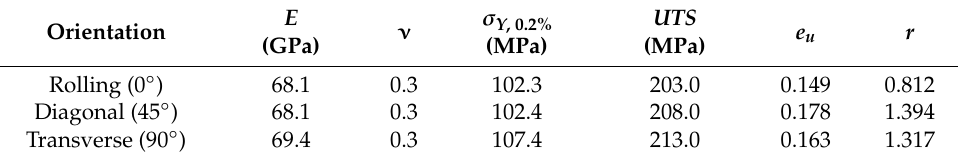
Figure 1. ( a ) True stress vs. true strain at rolling, diagonal and transverse directions; ( b ) experimental data and fittings of true stress vs. plastic true strain at rolling direction. Table 1. Mechanical properties for AA7075-O sheets at 0 ◦ , 45 ◦ and 90 ◦